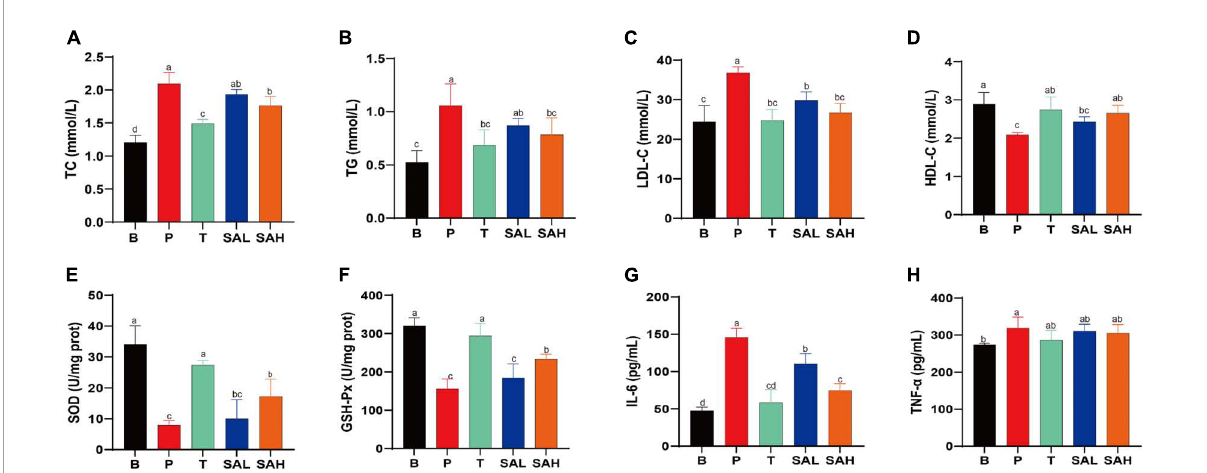
FIGURE2 Sciadonic acid (SA) regulated the serum metabolic parameters in type 2 diabetes mellitus (T2DM) mice. (A) TC, (B) TG, (C) LDL-C, (D) HDL-C, (E) SOD, (F) GSH-Px, (G) IL-6, and (H) TNF-a. Data are presented as the mean ± SD of three experiments. Different letters represent a significant difference among multiple groups ( P < 0.05). B, control group; P, diabetic model group; T, (HFD + 200 mg kg – 1 Met); SAL, (HFD + 70 mg kg – 1 SA); SAH, (HFD + 280 mg kg – 1 SA).